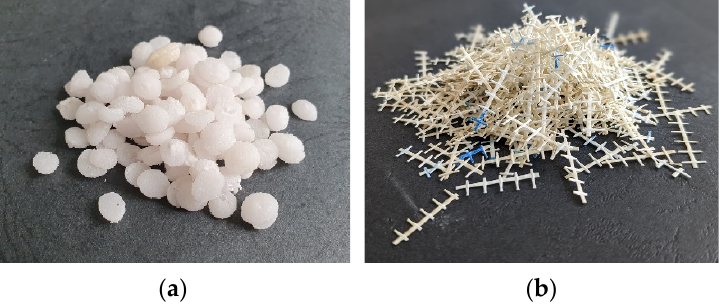
Figure 2. ( a ) Solidified waste alkalis based on sodium hydroxide (WAA); ( b ) fibers from the waste fiberglass reinforcement fabric (WFF).